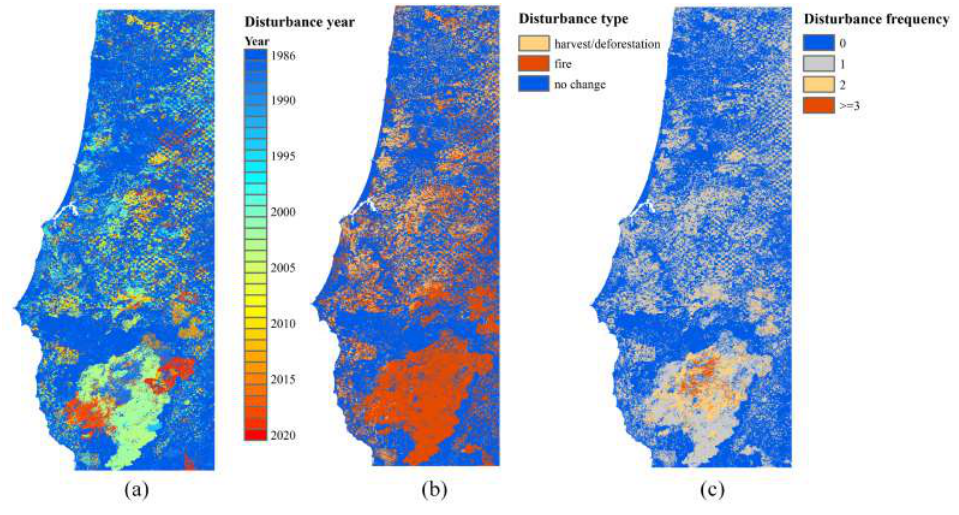
Figure 6. ( a – c ) Disturbance mapping results on disturbance point, type, and